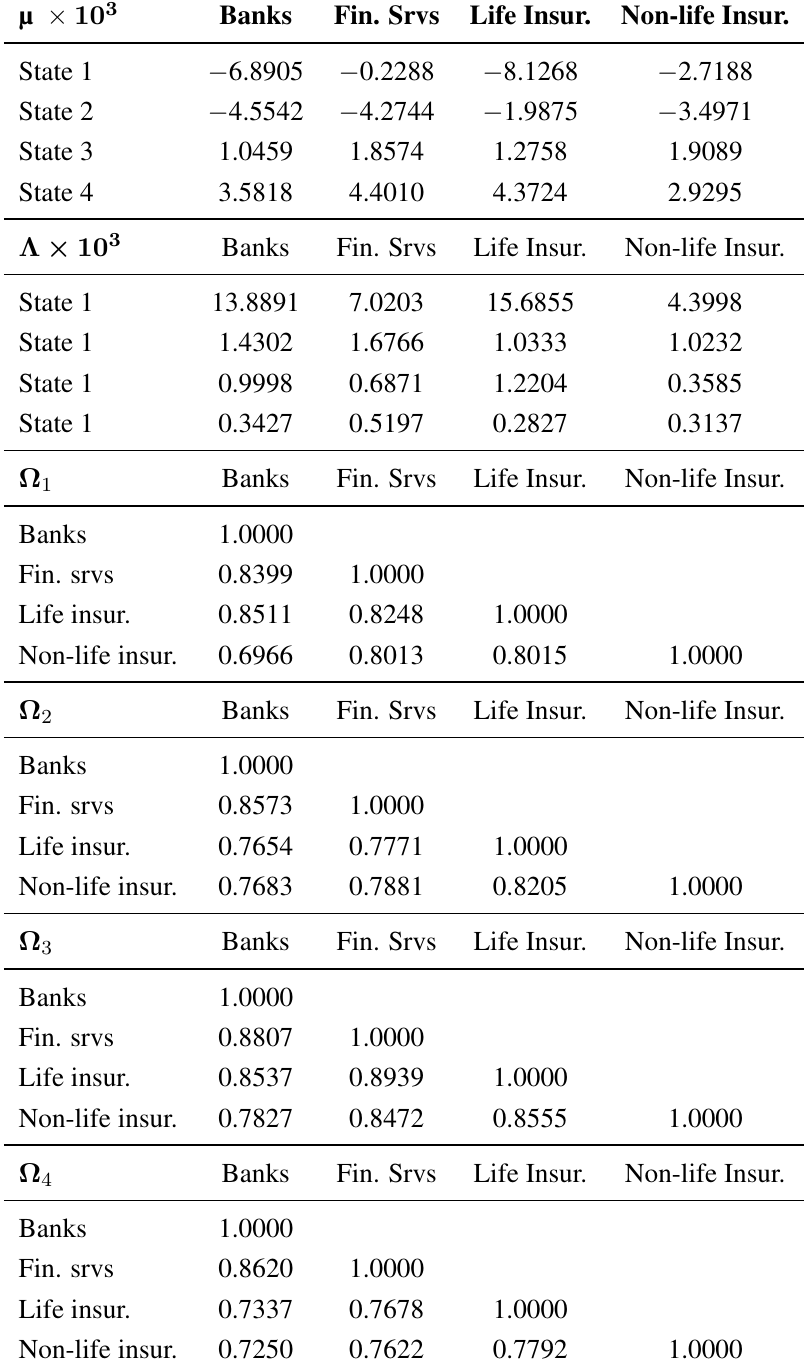
Table 3. Maximum likelihood parameter estimates of the selected Student- t MS model with four components. µ , for l = 1 ; 2 ; : : : ; L , denote the location parameters, while the diagonal l matrices Λ and the full matrices Ω for l = 1 ; 2 ; : : : ; L are such that Σ l l Σ is the scale matrix of the Student- t distribution. l Life